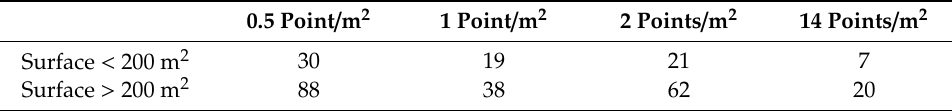
Table 7. Average RMSE (m 2 ) per point cloud density for residential buildings.